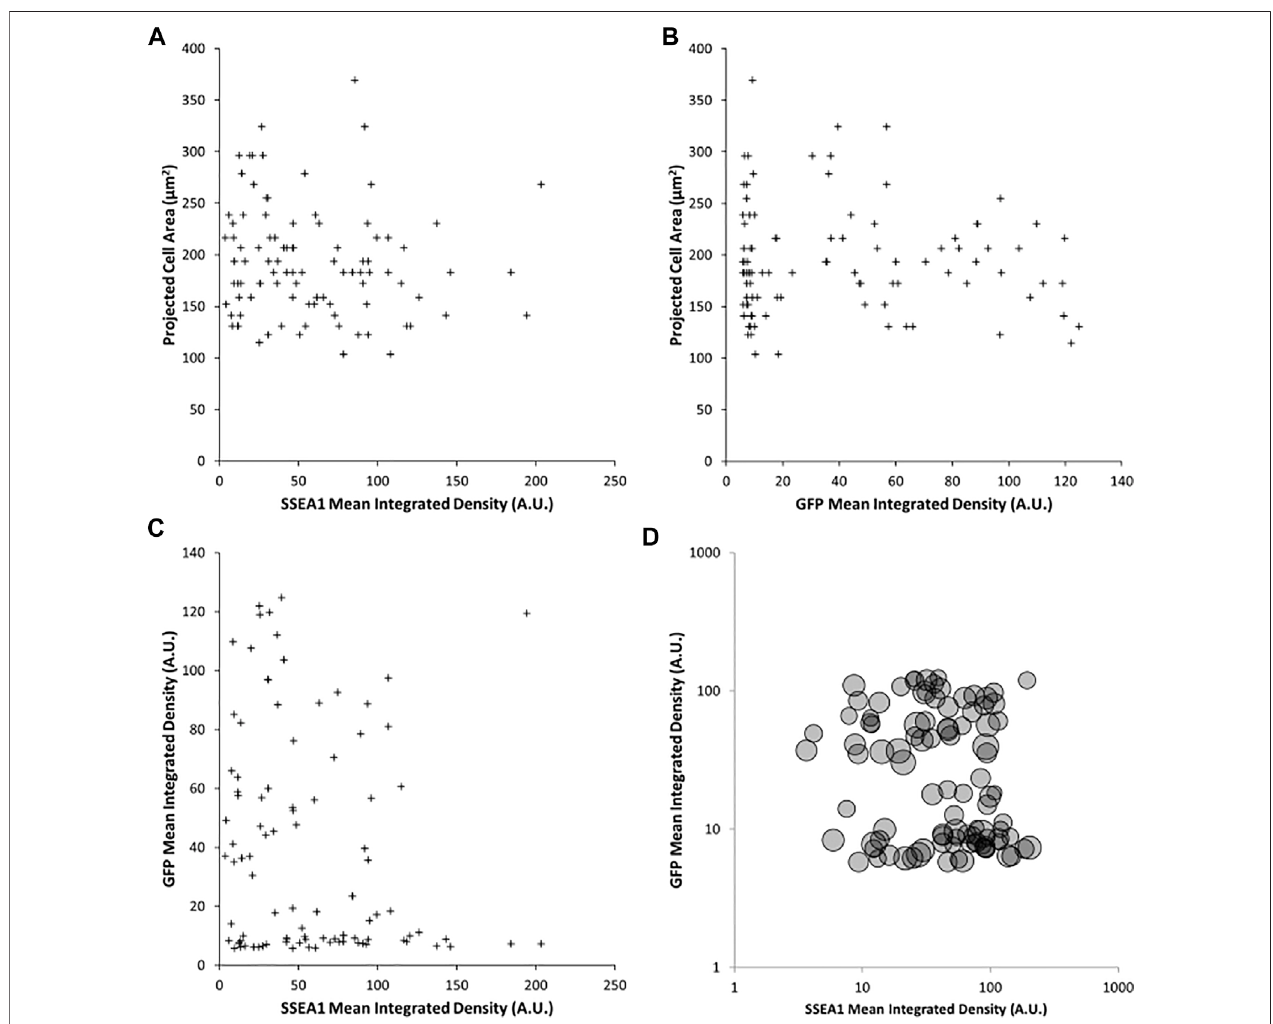
FIGURE 5 | Effect of Rex1 expression and SSEA1 abundance on cell volume. Live Rex1-GFPd2 cells cultured in LIF/FBS were enzymatically dissociated, labelled with an anti-SSEA1 antibody and imaged in suspension in phase contrast and fl uorescent modes. Cells in suspension are assumed to adopt a spherical shape, so cell volumecanbeestimated fromprojectedarea.ProjectedareaofdetachedRex1GFPcellsweaklycorrelatestoSSEA1abundance[ (A) , R =0.261, p =0.034],andRex1- dependent GFP fl uorescence [ (B) , R = − 0.306, p = 0.002]. Surprisingly, there is no apparent correlation between SSEA1 abundance and Rex1 -dependent GFP expression [ (C) , R = − 0.167, p = 0.102]. There is no covariance in terms of the effect of these pluripotency markers on cell volume [ (D) , circle areas correspond to projected cell areas]. n = 97, Pearson correlation test.